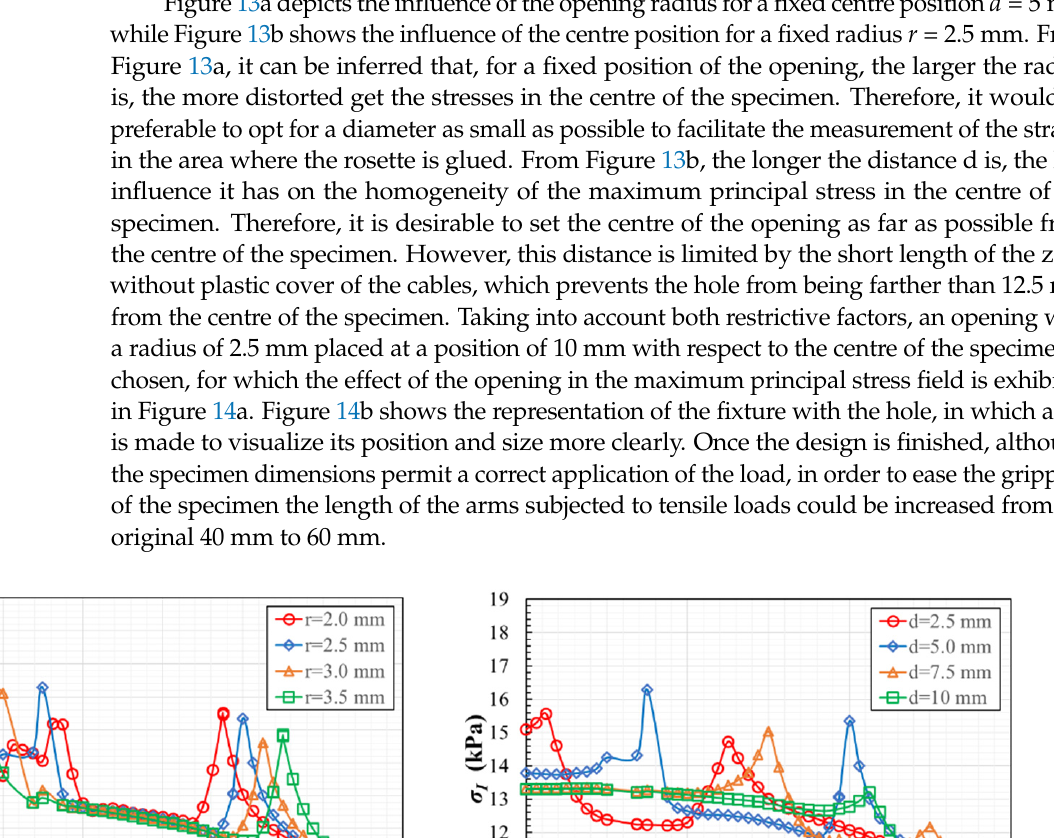
Figure 13. In geometry A for the CCC loading case: ( a ) influence of the opening radius for d = 5 mm; ( b ) influence of the centre position for r = 2.5 mm.